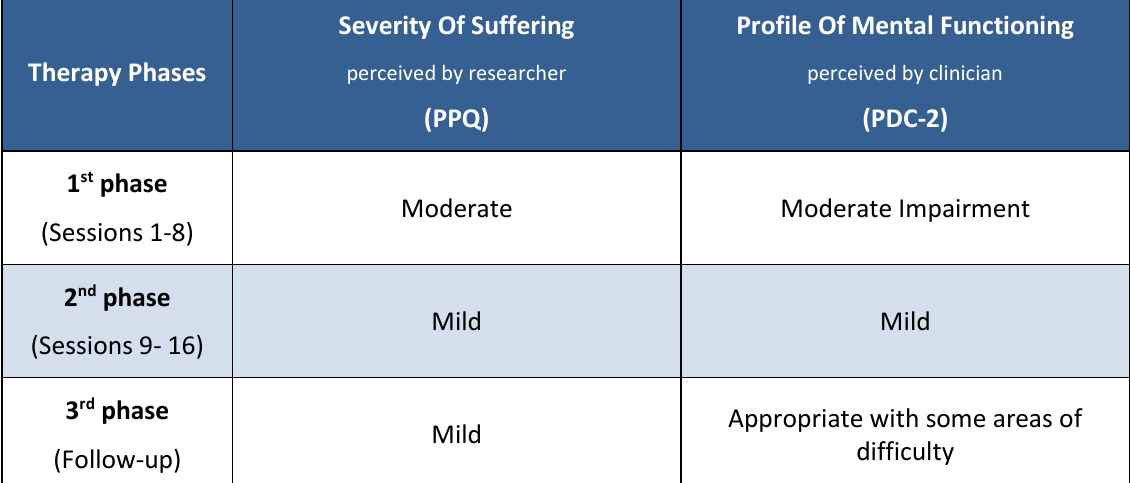
Table 3: Convergent comparison of PPQ with PDC-2